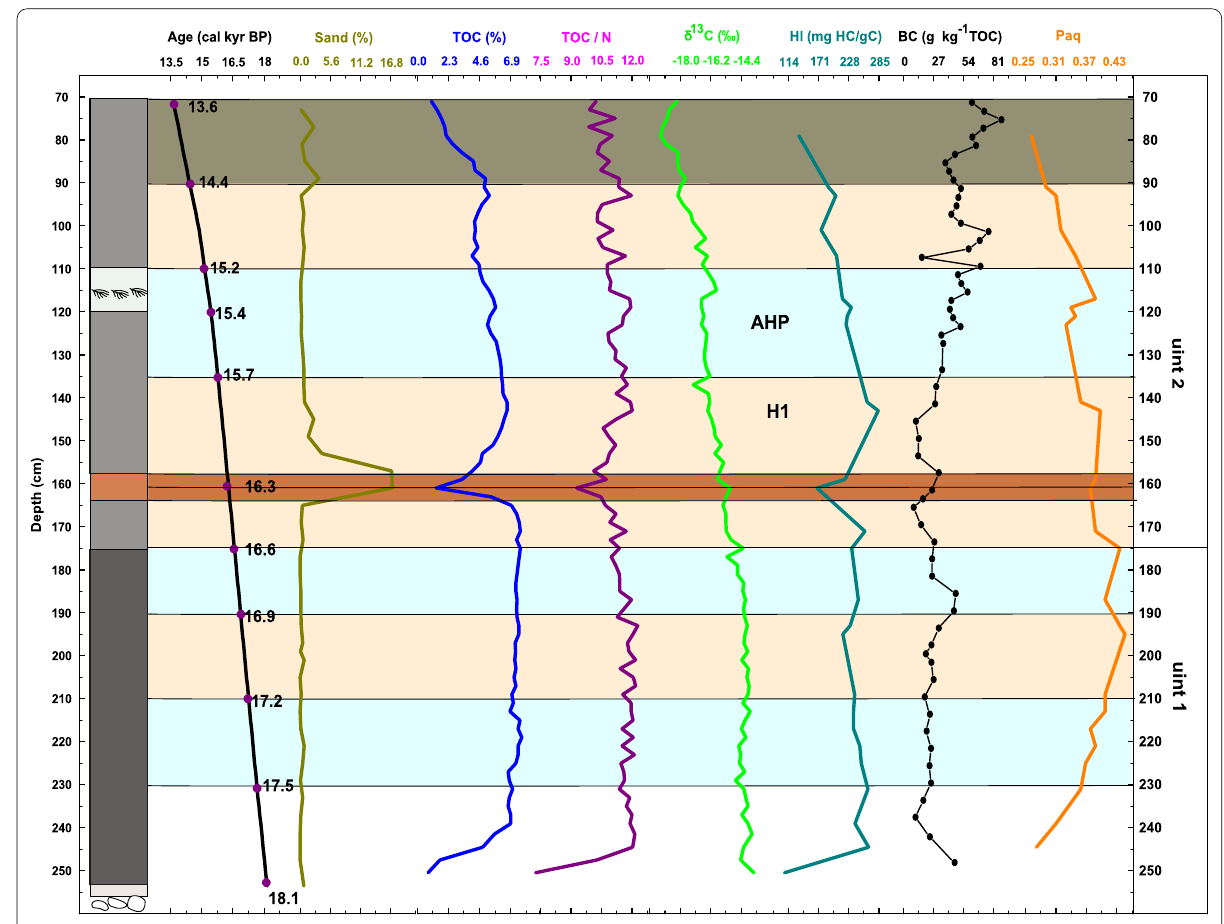
Fig. 4 Analytical properties of the B4 sediments, with depth profiles of the sand fraction (63–2000 μm), total organic carbon (TOC), organic carbon‑to‑nitrogen ratio (TOC/N), Hydrogen Index (HI), δ 13 C values, Black Carbon (BC) and Paq. The light orange color shows dryer events while orange color indicates desiccation layers developed during Heinrich Event 1(H1). Blue color indicates the African Humid Period (AHP) and other humid episodes while dark green color indicates the event characterized as humid and arid according to pollen and geochemical results,